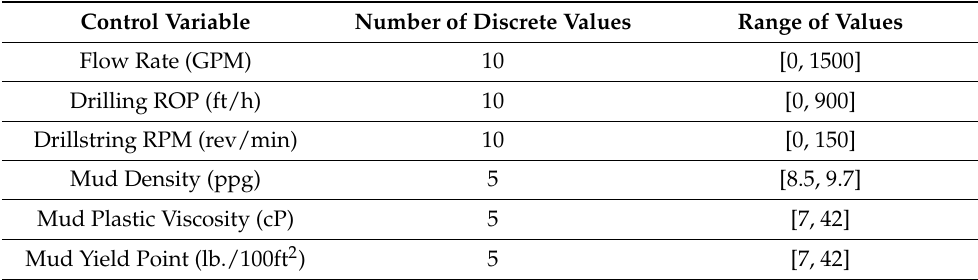
Table 4. Value discretization of control